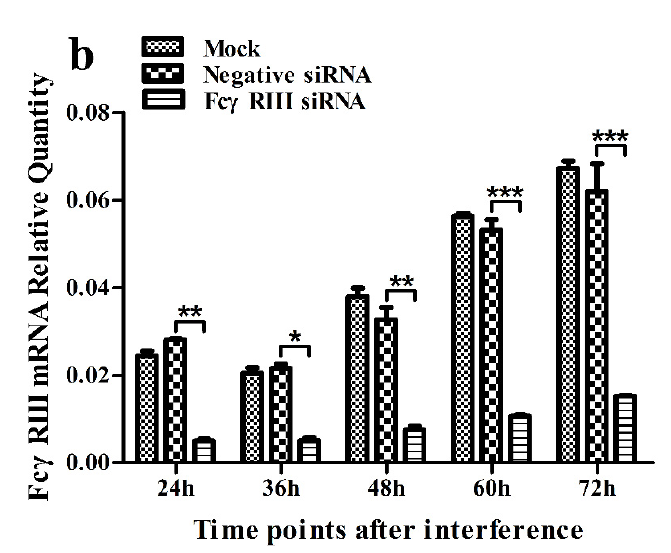
Figure 5. Relative quantitative RT-PCR analysis of mRNA expression of Fc γ RI or Fc γ RIII in porcine AMs. ( a ) Relative quantitative RT-PCR analysis of Fc γ RI mRNA level in cells transfected with Fc γ RI siRNA or negative siRNA. ( b ) Relative quantitative RT-PCR analysis of Fc γ RIII mRNA level in cells transfected with Fc γ RIII siRNA or negative siRNA. *** p < 0.001, ** p < 0.01, * p < 0.05. Note: siRNA: small interfering RNA; Fc γ RI: Fc gamma receptor I; Fc γ RIII: Fc gamma receptor III.